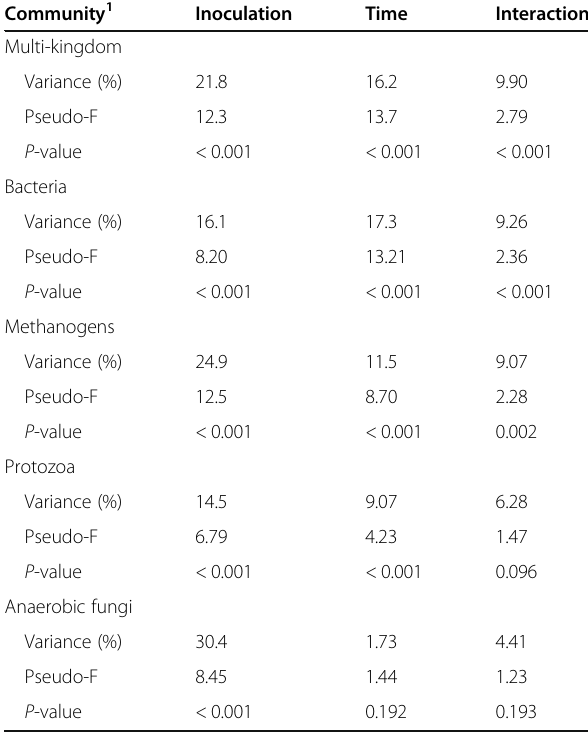
Table 1 Permutational analysis of variance describing the effects of early-in-life rumen microbial inoculation and time on the rumen community